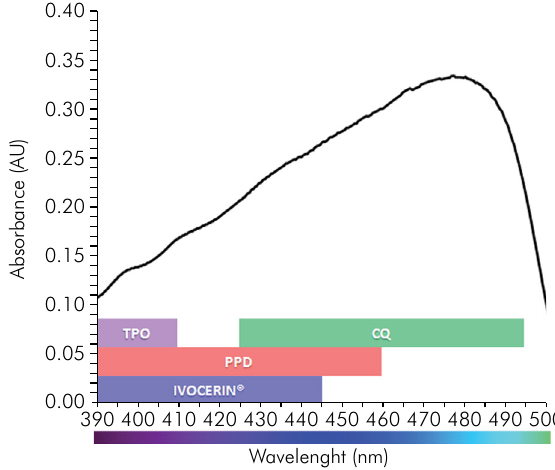
Figure 15. Spectral emission profile of a typical QTH light with absorption wavelength ranges for typical dental photoinitiators.